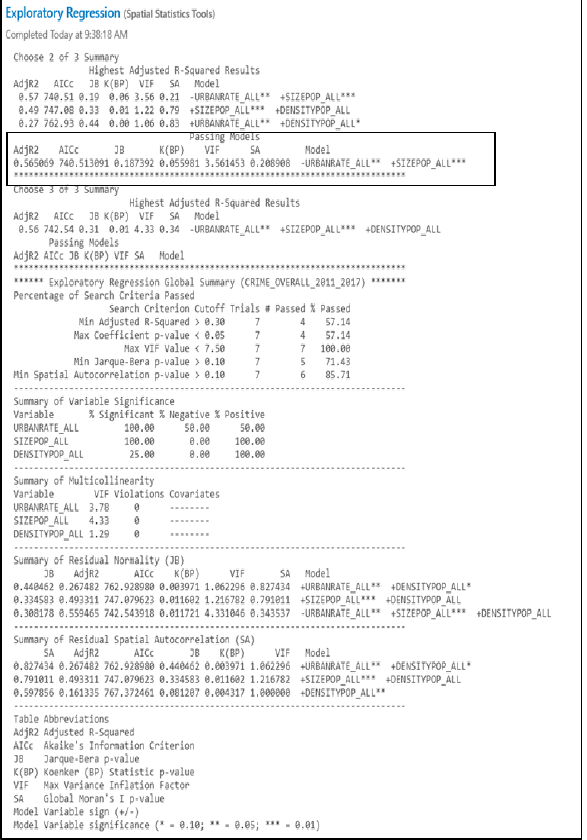
Table 3: Exploratory Regression result for urban crime factors